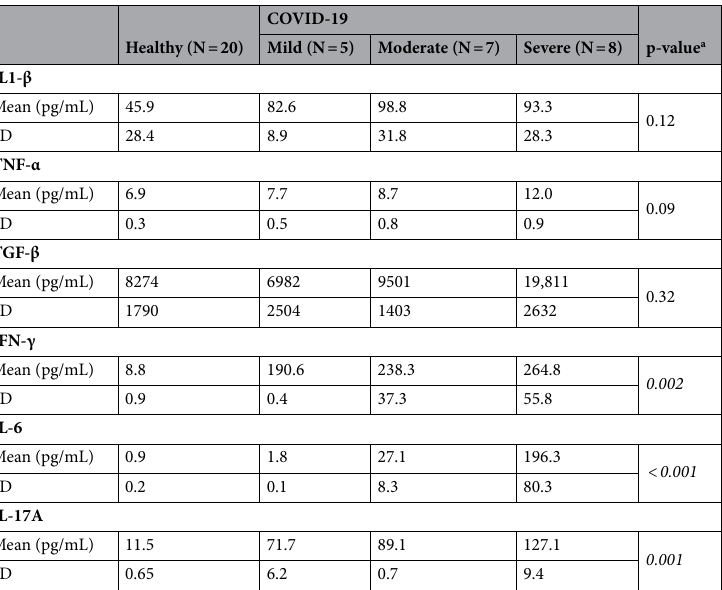
Table 2. Concentration in peripheral blood of cytokines involved in the immune response in patients recently admitted at COVID-19 Units. Significant values are in italics. a ANOVA test for the comparison of cytokine in COVID-19 patients, results are reported as means and standard